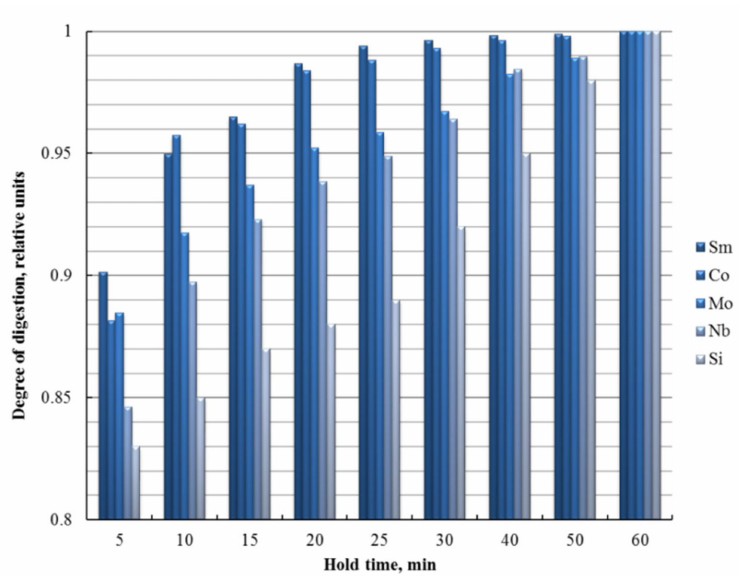
Figure 1. The dependence of the recovery of the elements on hold time.